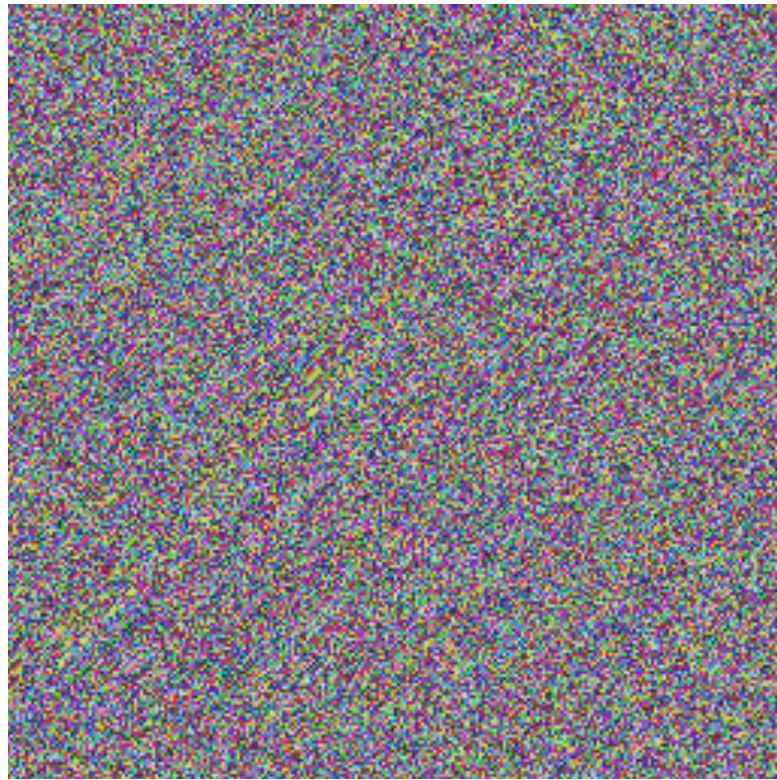
Figure 5. Latin square of order 256 represented by colors.